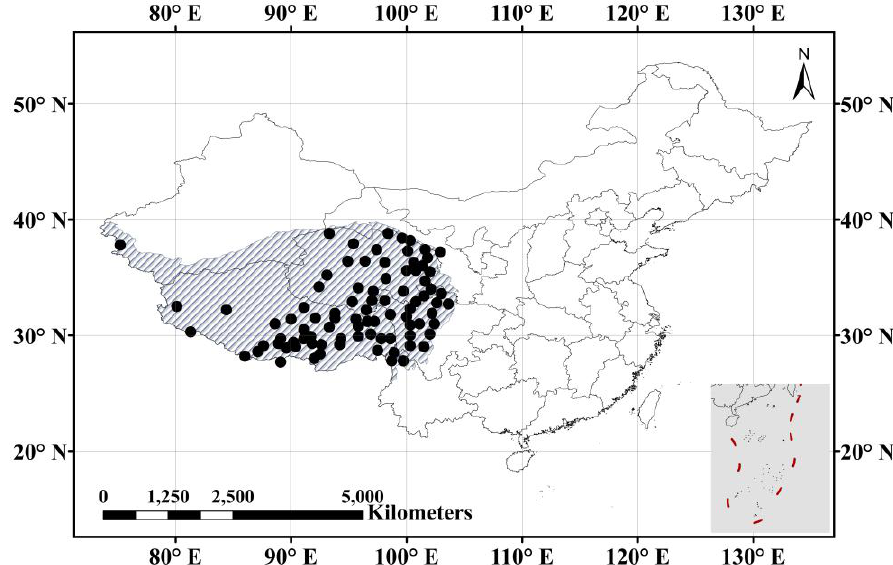
Figure 1. Distribution of meteorological stations over Qinghai-Tibetan Plateau in China. The gray shaded area indicates the region of the Qinghai-Tibetan Plateau, and the dots show the 87 meteorological stations.